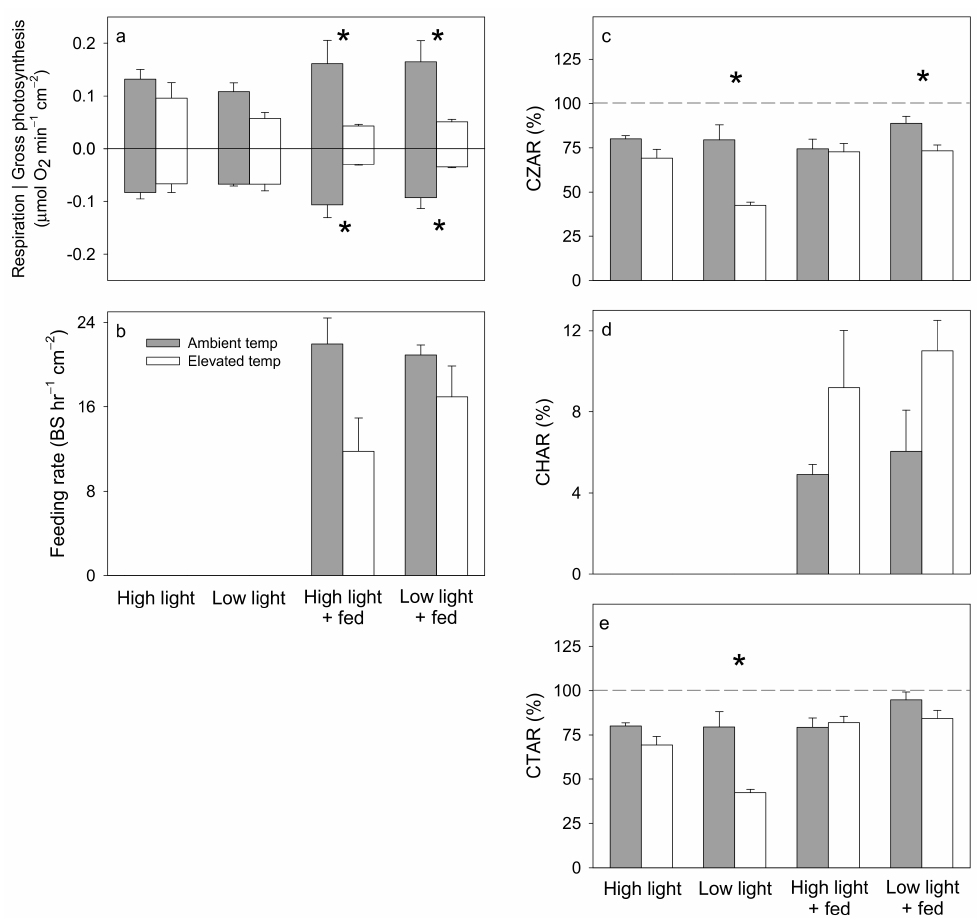
Figure 6. Stylophora pistillata average ( ± 1 SE) ( a ) photosynthesis and respiration, ( b ) feeding rate, ( c ) Contribution of Zooxanthellae (Symbiodiniaceae) to Animal Respiration (CZAR), ( d ) Contribution of Heterotrophy to Animal Respiration (CHAR) from feeding on Artemia nauplii, and ( e ) Contribution of Total acquired fixed carbon relative to Animal Respiration (CTAR), under ambient temperature (25 ◦ C, solid bars) and elevated temperature (30 ◦ C, open bars) within high light (300 µ mol pho- tons m − 2 s − 1 , unfed), low light (150 µ mol photons m − 2 s − 1 , unfed), high light + fed (300 µ mol photons m − 2 s − 1 , fed), and low light + fed (150 µ mol photons m − 2 s − 1 , fed) treatments. Asterisks in- dicate significant differences between ambient and elevated temperature treatments within each light and feeding treatment combination. N = 3 for all averages. Significant effects from the corresponding ANOVAs in Table